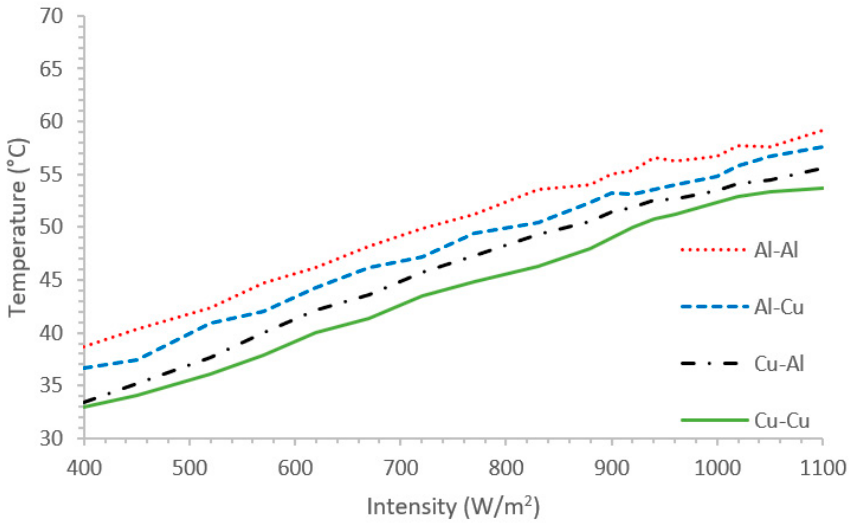
Figure 8. The relationship between solar intensity and temperature of photovoltaic solar panels.